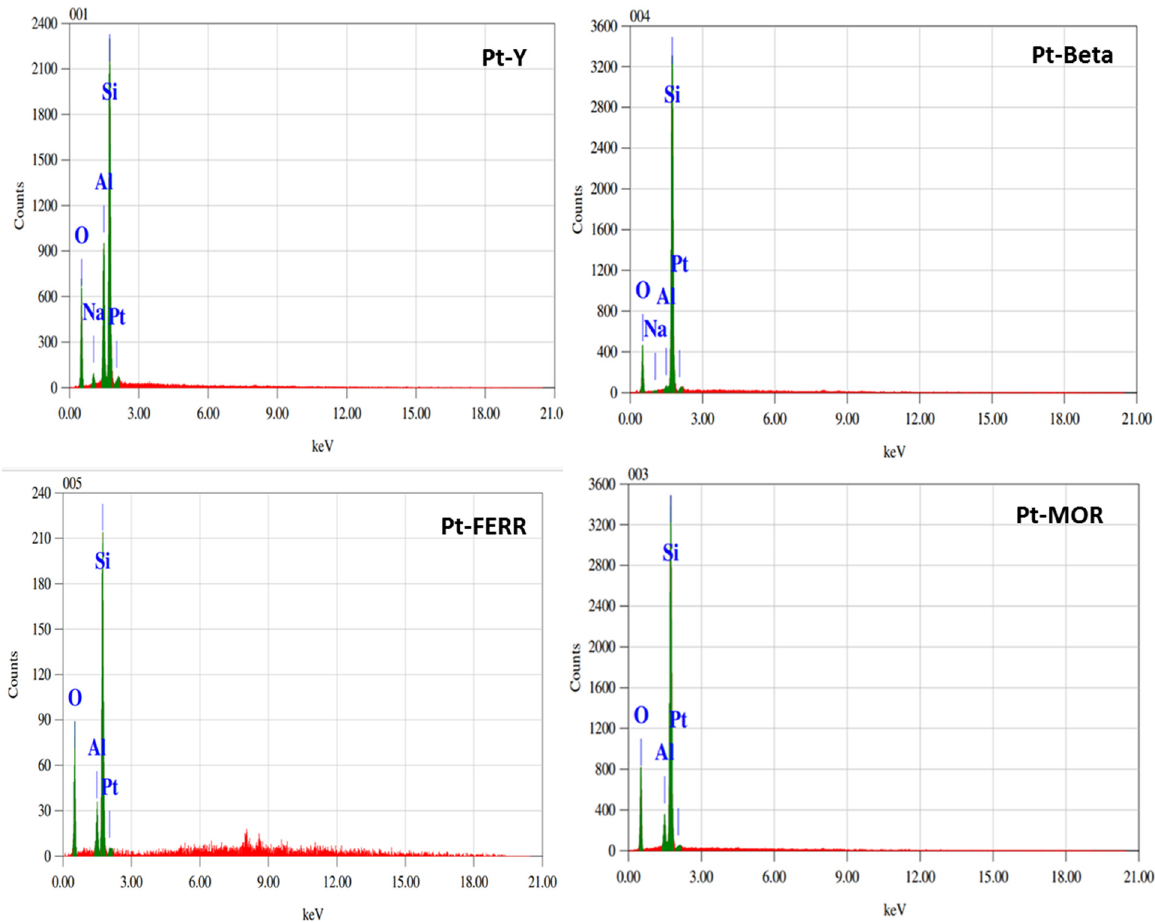
Figure 5. The EDX analysis of the prepared Pt-incorporated zeolite materials (Y, Beta, MOR, and FERR).